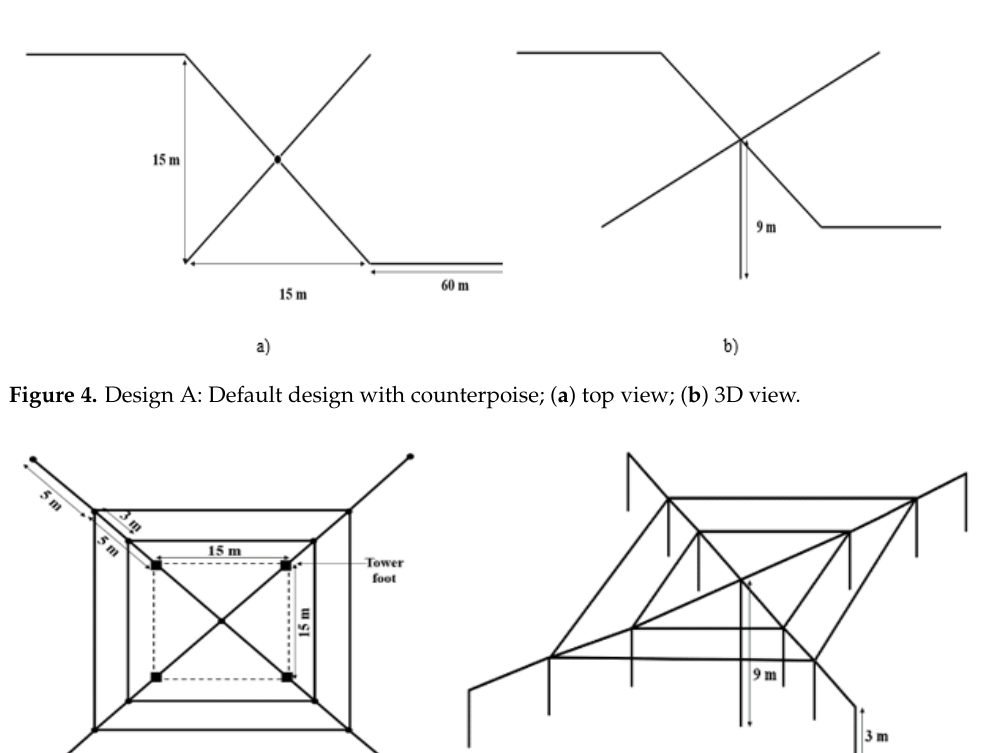
Figure 4. Design A: Default design with counterpoise; ( a ) top view; ( b ) 3D view.